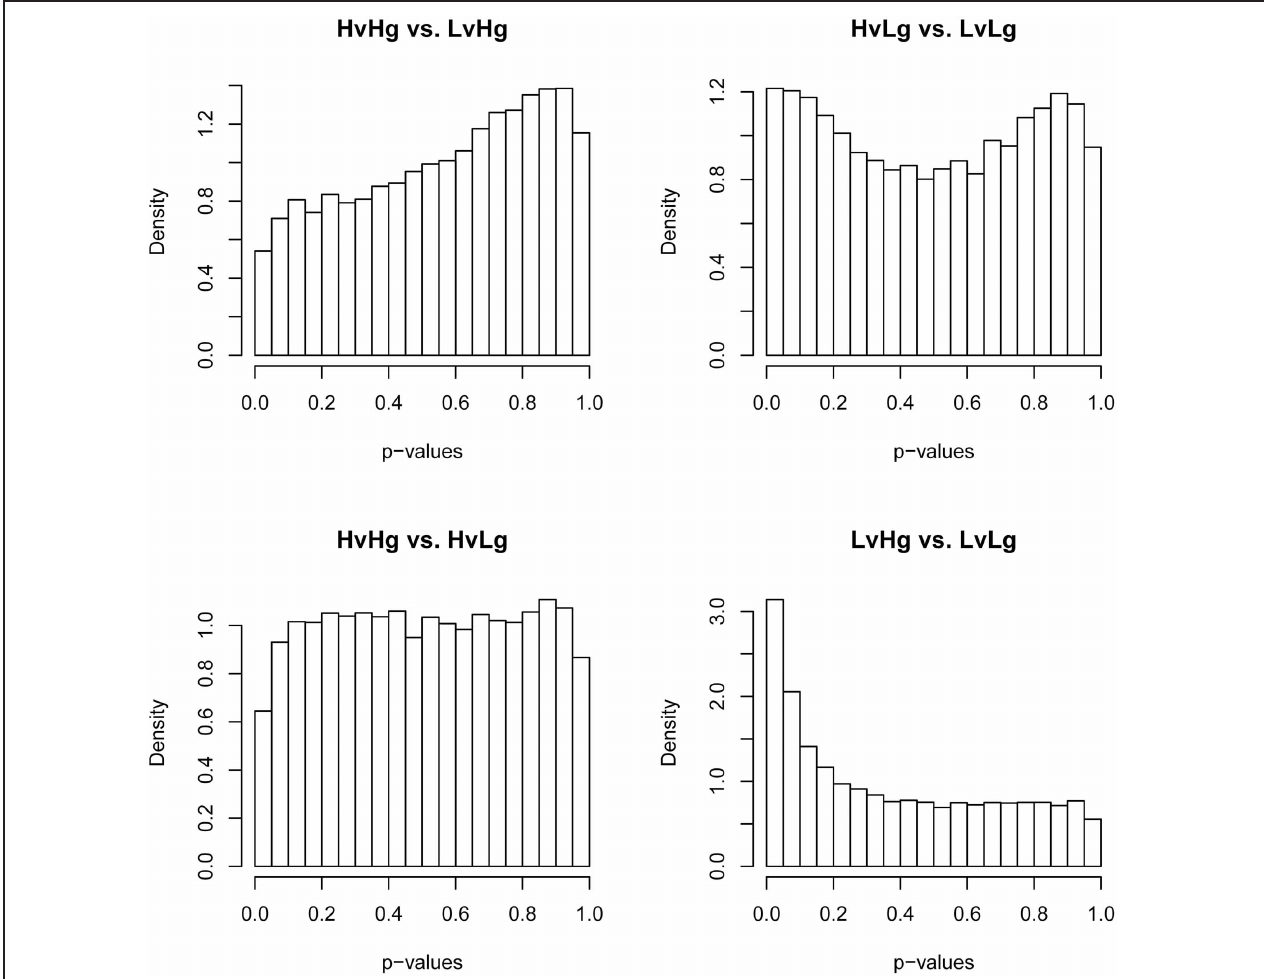
FIGURE 2 | Histogram of p -values for the four contrasts of interest at 0DPI. For each contrast of interest (HvHg vs. LvHg, HvLg vs. LvLg, HvHg vs. HvLg, and LvHg vs. LvLg), this figure shows the distribution of p -values at 0DPI. For a condition of no differential expression the histograms should have a flat